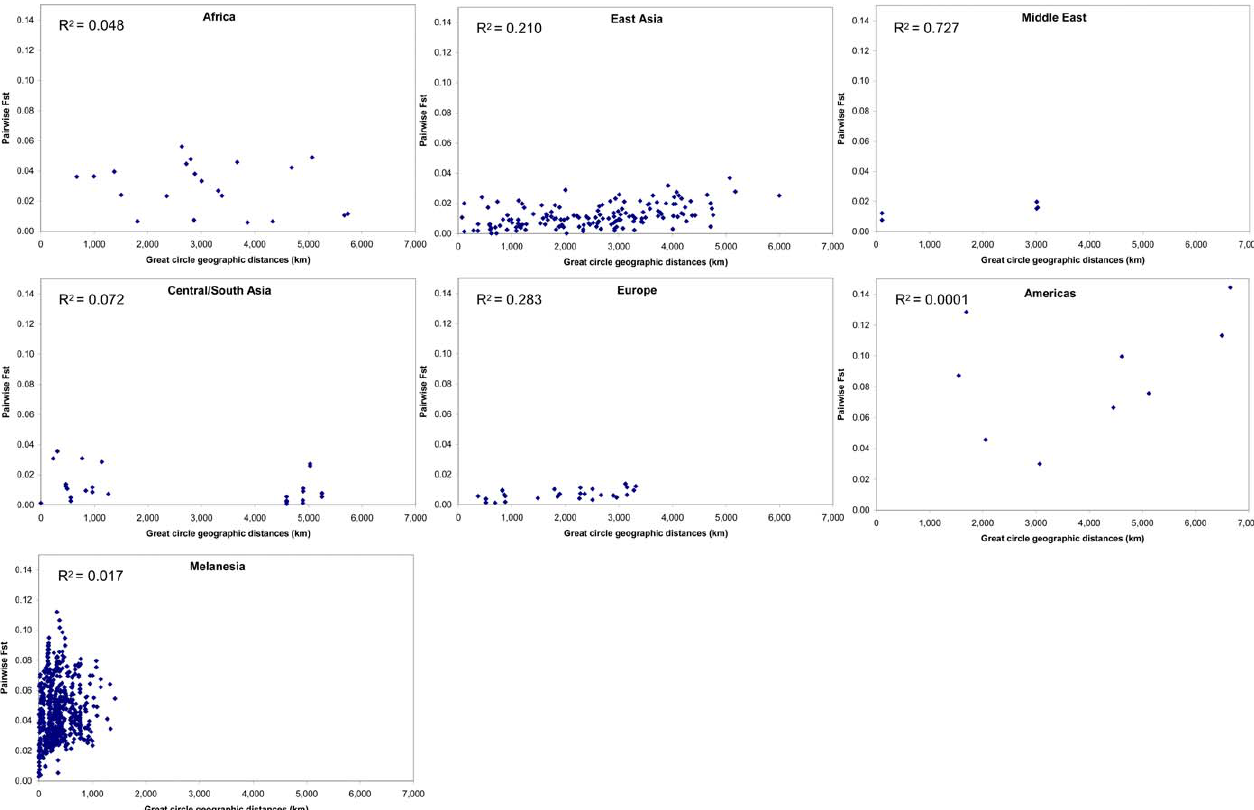
Figure 3. Genetic versus Geographic Distances within Continents